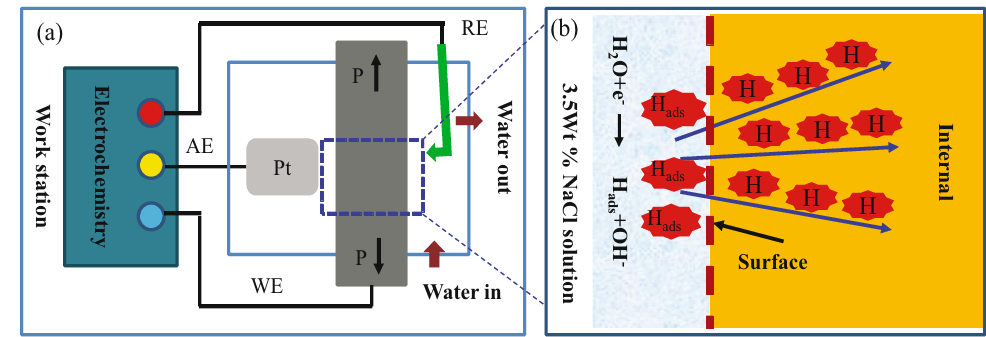
Figure 1: Schematic diagram of test design: ( a ) synchronously applied cathode potential of SSRT test and ( b ) hydrogen atoms adsorbed on the surface of the material and di ff using into the material under the action of cathode potential.